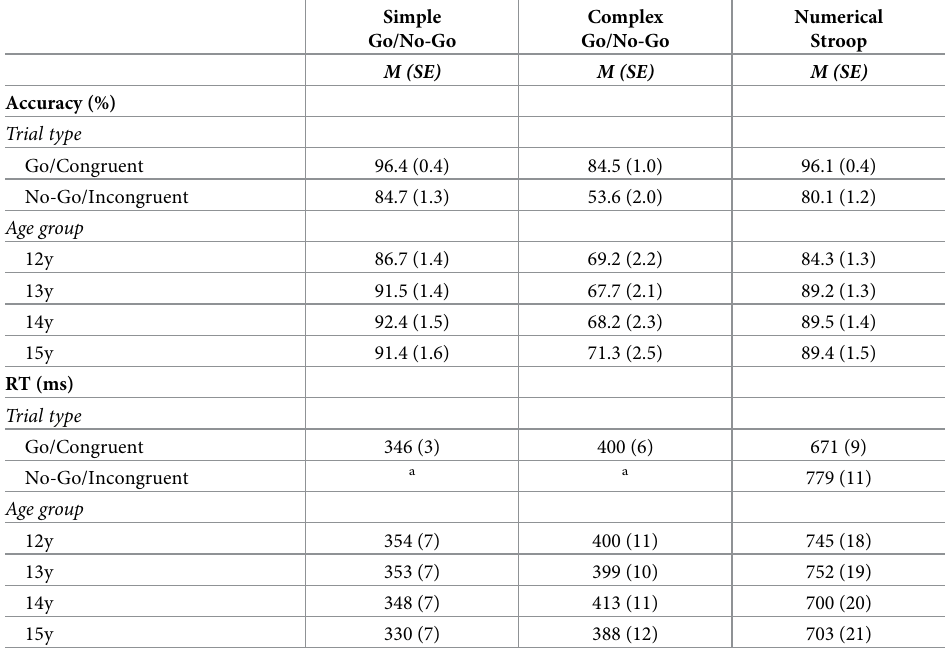
Table 3. Accuracy and RT estimated marginal means in the inhibitory control